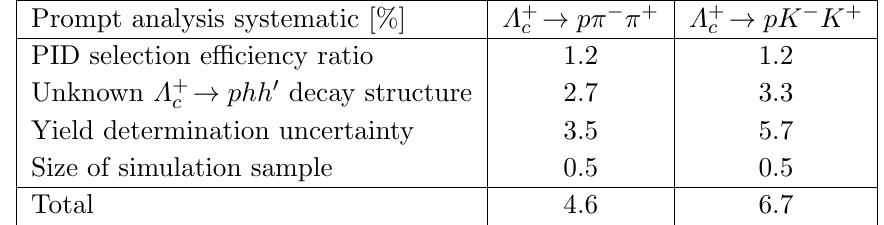
Table 4 . Relative systematic uncertainties in each ratio of branching fractions, for the prompt